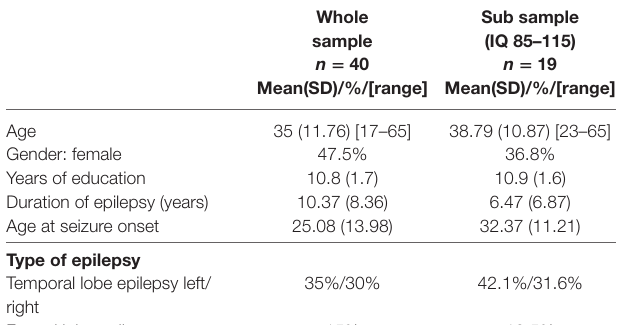
TaBle 1 | Demographic and epilepsy